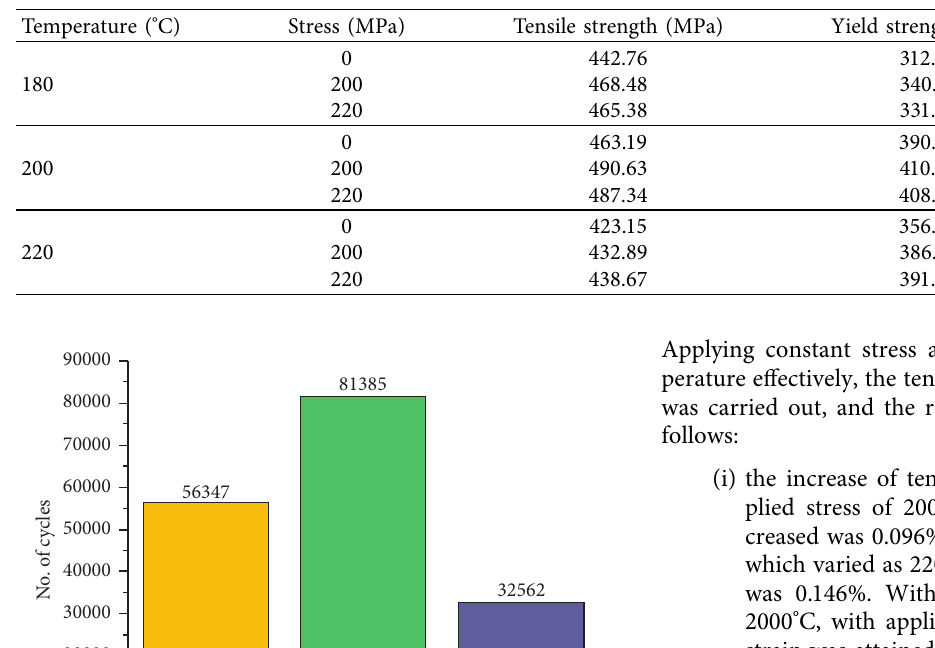
Table 3: Mechanical strength of Al-Zn-Mg alloy after creep aging.